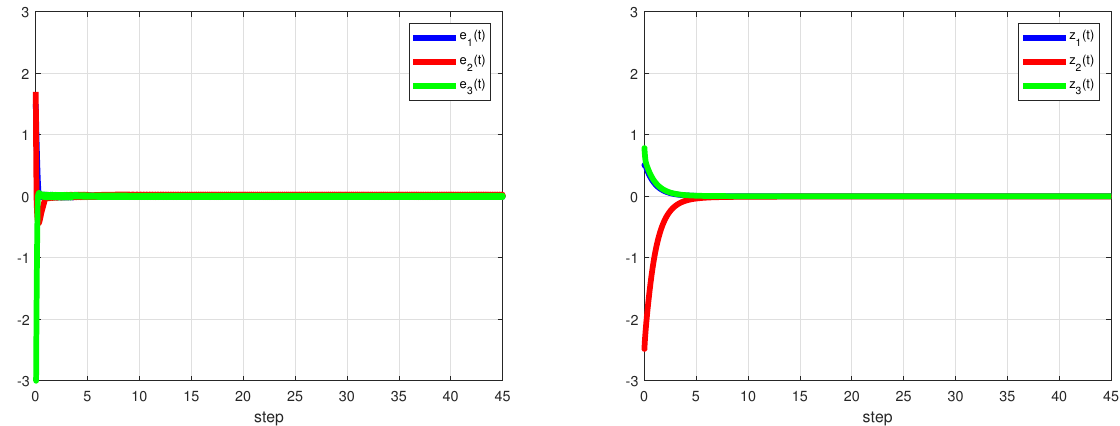
Figure 9. Time behaviors of error signals e 1 ( t ) , e 2 ( t ) , e 3 ( t ) , z 1 ( t ) , z 2 ( t ) and z 3 ( t ) without control input in Example 2.